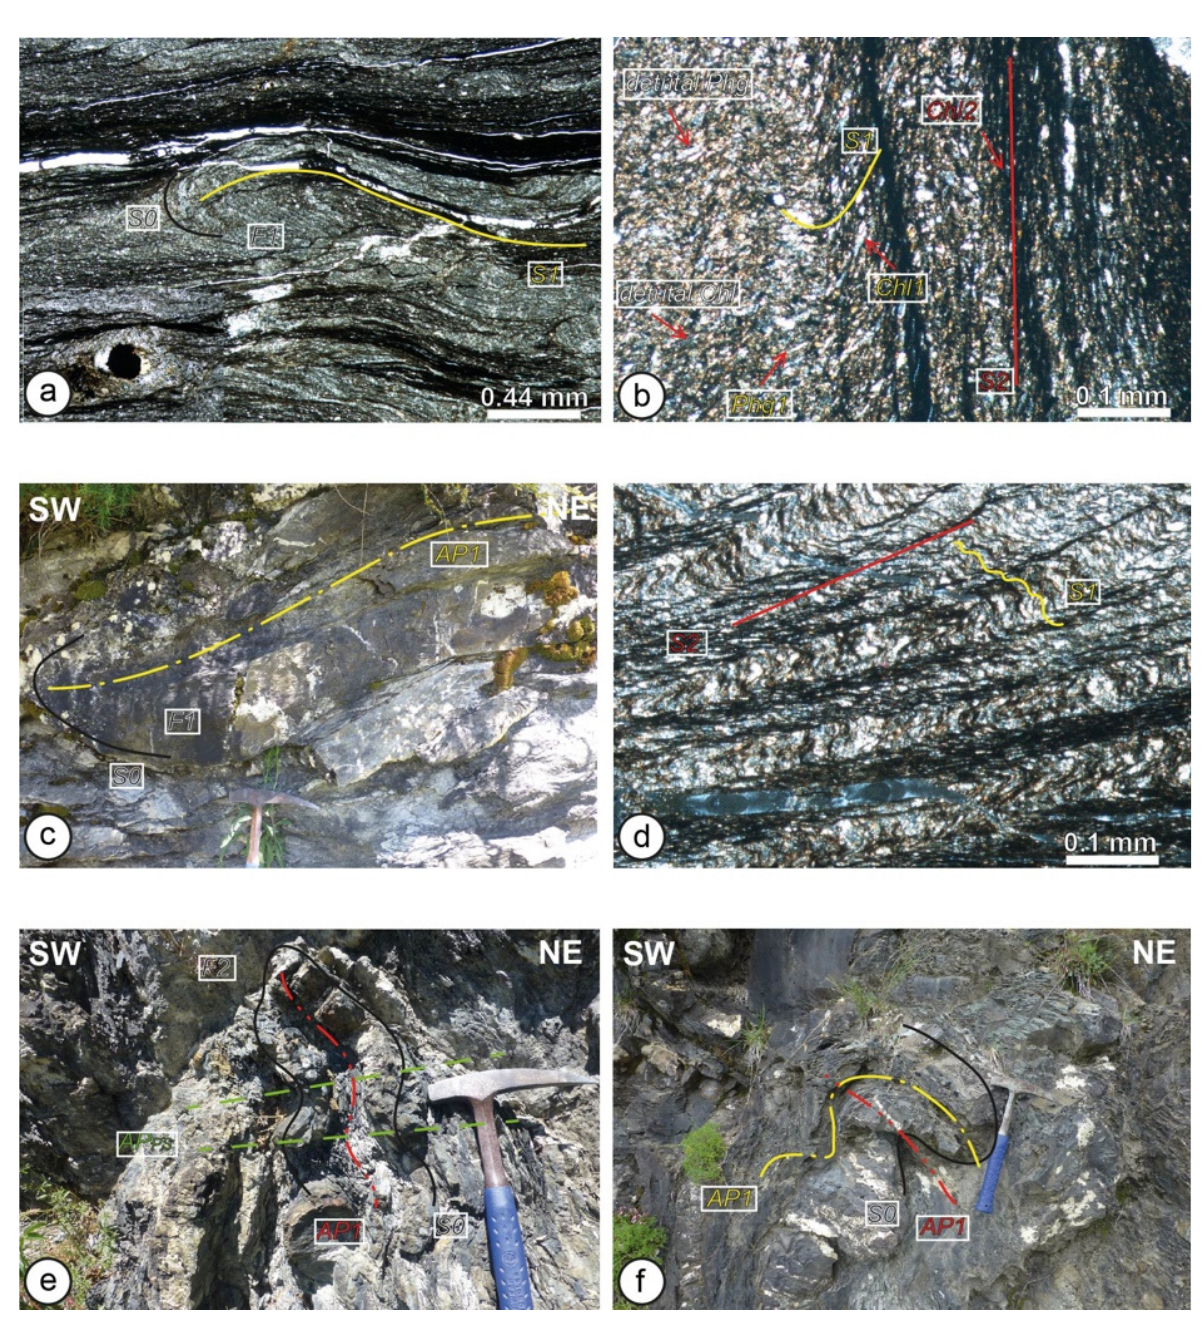
Figure 5. Micro- and meso- photographs of the D1 and D2 phases’ structural features. ( a ) S1 foliation associated to F1 micro-fold (Palombini Shale). On the bottom left, a close-up of pirite with quartz rich re-crystallization tails is evident; ( b ) Microphotographs of S1 and S2 foliation; ( c ) Mesoscopic F1 fold (Palombini Shale); ( d ) Micro-scale S2-S1 cross-cutting relationships (Pieve di Teco Formation); ( e ) Mesoscopic F2 fold deformed by post-coupling structures; ( f ) Meso-scale F2-F1 interference pattern (Palombini Shale). Chl 1–2 : D1 and D2 phase-related chlorite; Phg 1–2 : D1 and D2 phase- related phengite; S0: bedding; F1: D1 phase folding system; F2: D2 phase folding system; AP1: D1 phase-related axial plane; AP2: D2 phase-related axial plane.